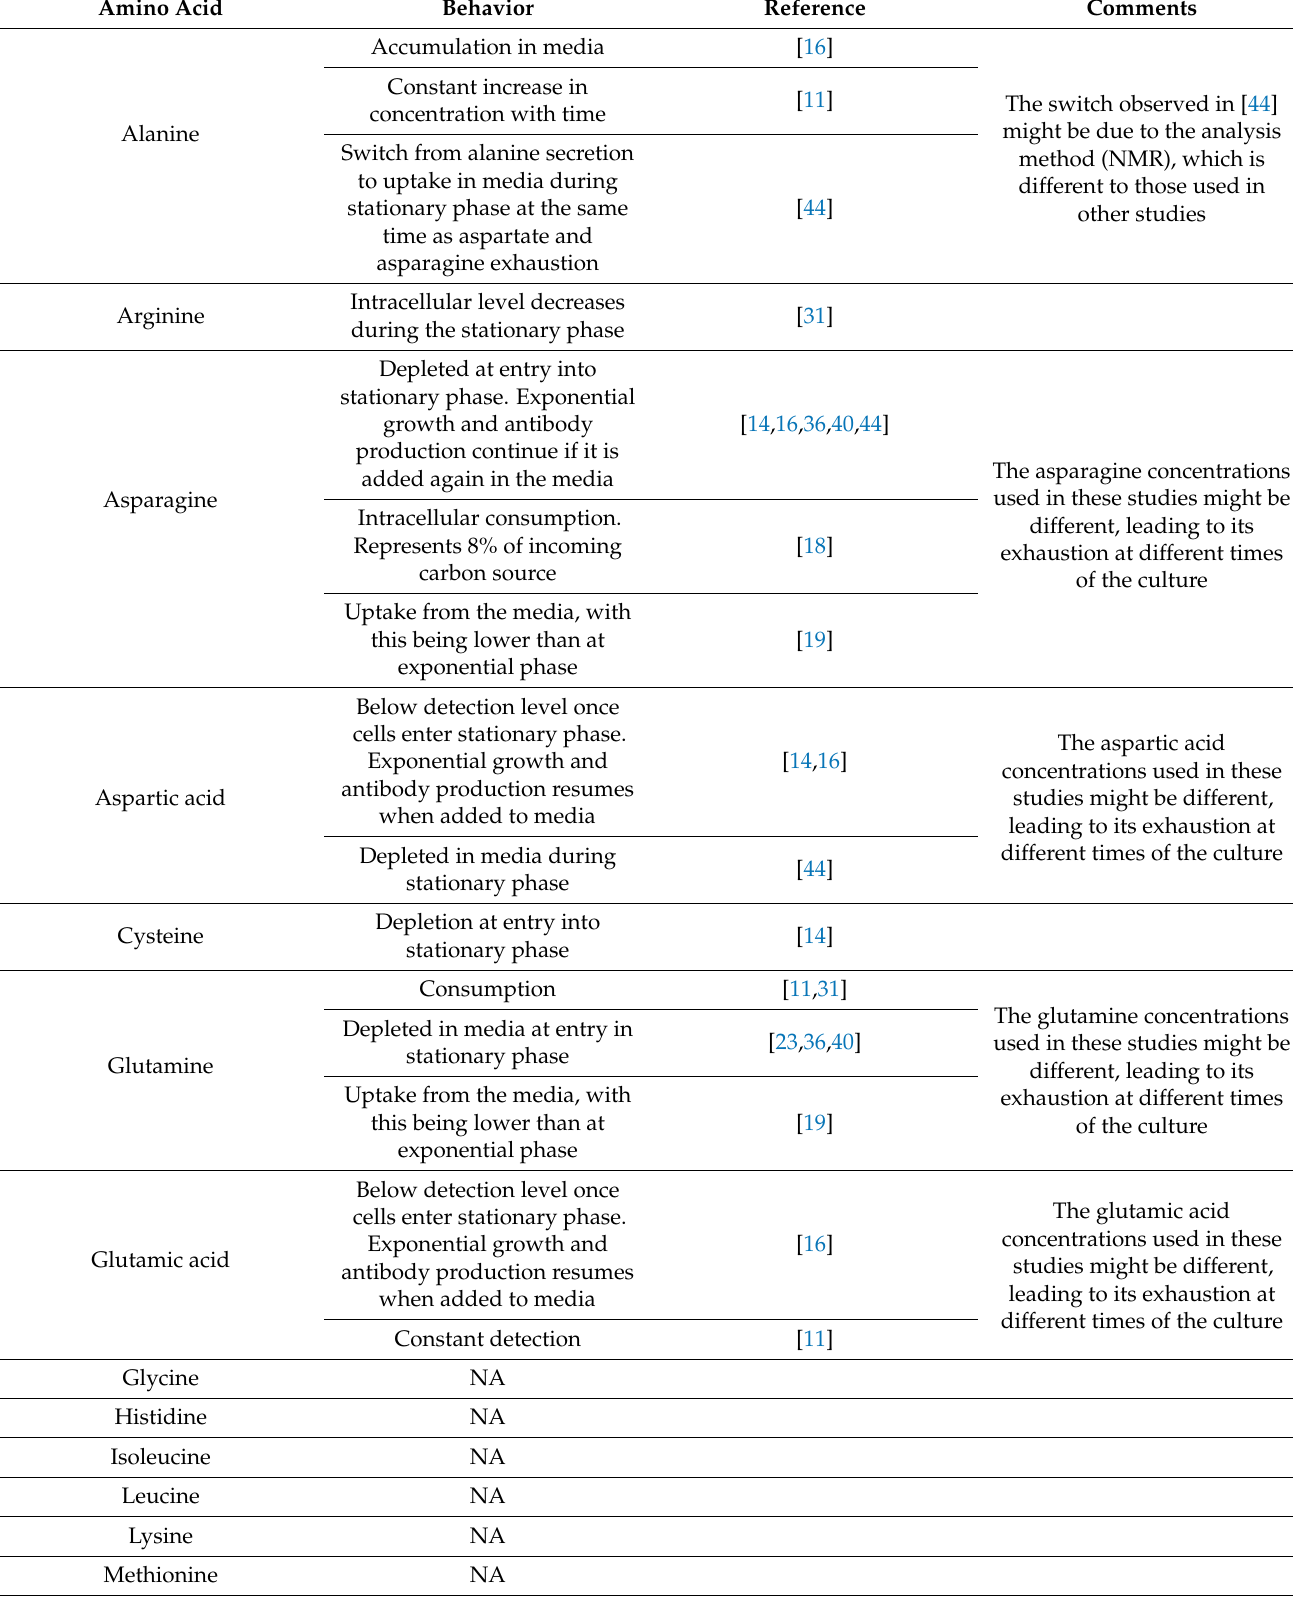
Table 2. Amino acids and amino acid derivatives at the stationary